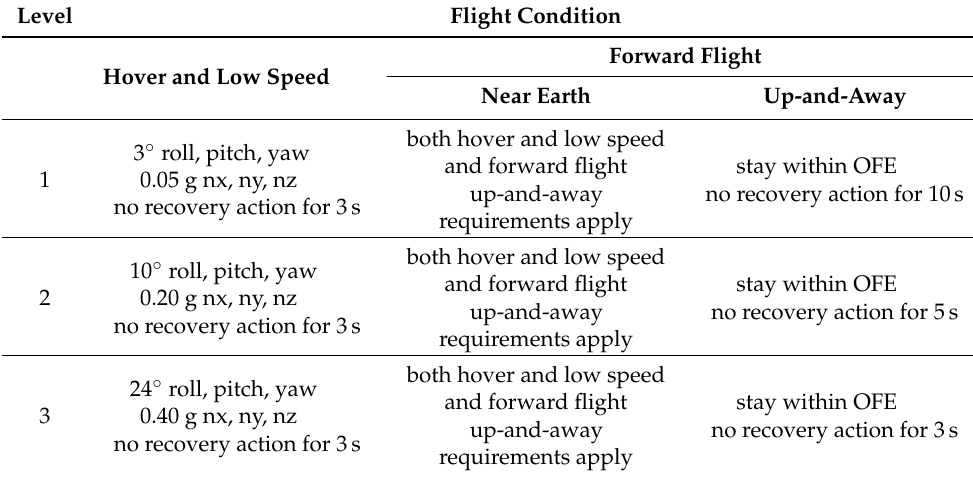
Table 8. Requirements for helicopter motion transients following control system failures (ADS-33E- PRF